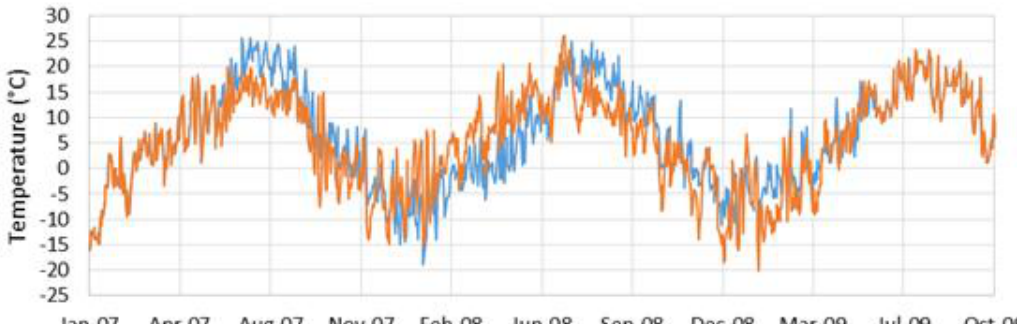
Figure 8. Results from the first realization of data imputation over a 730-day (2-year) gap. In this realization, the seasonal variation is recreated well, but there seems to be a timing offset with the imputed data lagging on the warming and cooling periods. However, the data peaks, both the seasonal highs and seasonal lows, are well timed.